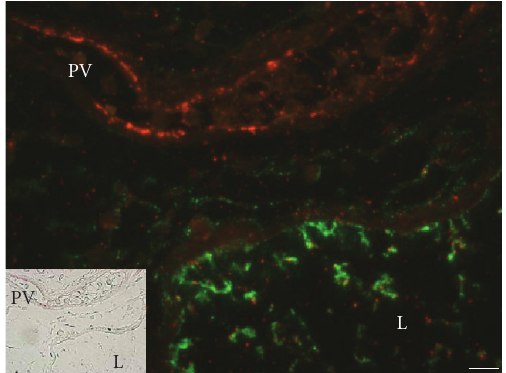
Figure 4: Immunohistochemistry of SP-D and KL-6/MUC1 in IPF lungs. Double-fluorescent immunohistochemistry for SP-D (in red) and KL-6/MUC1 (in green) in IPF lung tissues revealed SP-D-positive materials within both pulmonary veins (PV) and lymphatics (L). In contrast, KL-6/MUC1 was not included in pulmonary veins but only in lymphatics (scale bars = 10 μ